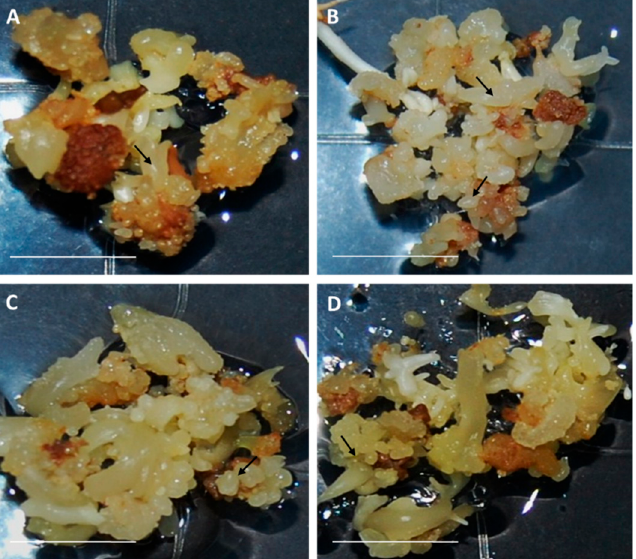
Figure 4. Appearance of olive embryogenic cultures ( A , C ) control and ( B , D ) derived from cryopreserved somatic embryos of the lines T1 ( A , B ) and P5 ( C , D ) after eight weeks in maturation medium. Arrows indicate somatic embryos. Bar = 1 cm.